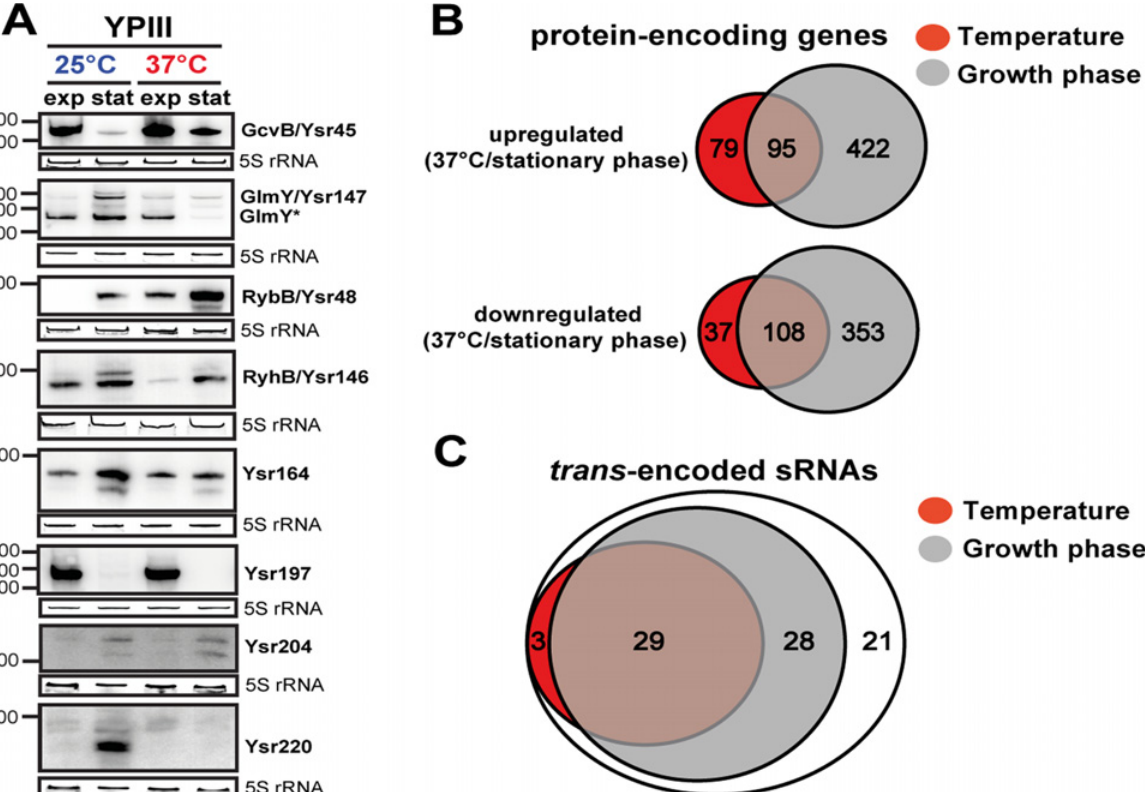
Fig 3. Temperature- and growth phase-responsive protein-encoding genes and trans -encoded RNAs. (A) Differential expression of trans -encoded sRNAs of YPIII shown by Northern blot analyses. RNA samples were prepared from bacteria grown to exponential (exp) or stationary phase (stat) at 25°C and 37°C. sRNAs were detected by specific radioactive labeled probes. 5S rRNA served as loading control. The size marker (nt) is indicated. Venn diagrams illustrating temperature and growth phase-regulated (B) protein-encoding genes and (C) trans -encoded sRNAs in Y . pseudotuberculosis YPIII. The regulons were obtained by comparative RNA-seq using DESeq from triplicate experiments (S3 and S4 Datasets). Protein- and trans -encoded RNAs which are differentially regulated by at least 4-fold (p-value (cid:1) 0.05) are included.